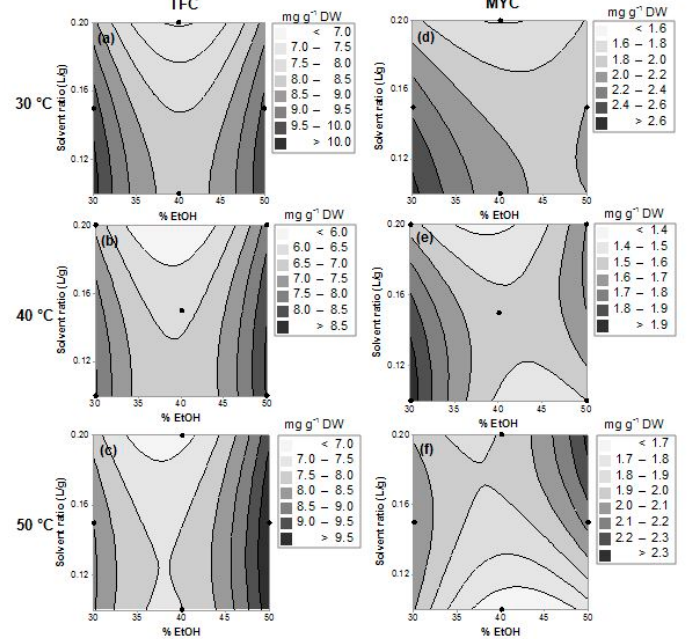
Figure 2. Response surface (contour plots) for predicting the TFC ( a – c ) and MYC ( d – f ) in P. lentiscus leaf extracts with regard to the ethanol fraction (%, x 1 ) and solvent ratio (x 2 ) used at each temperature (x 3 , 30, 40, and 50 °C). The regions with the darkest-gray or black color represent the domains of working conditions assuring the maximum values for the evaluated compounds (total flavonoids and myricitrin).